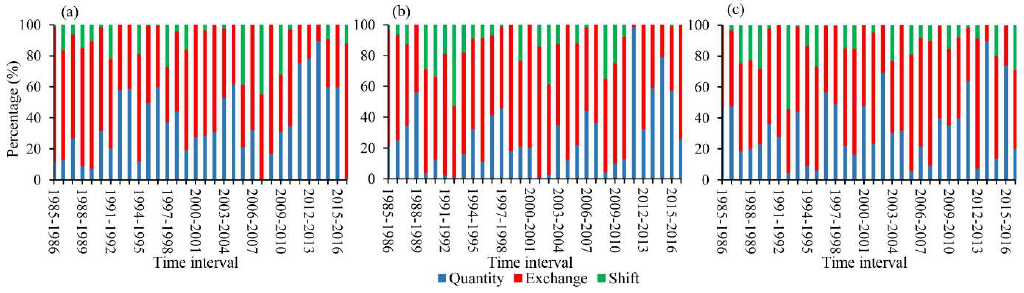
Figure 6. Percentage of water change components in ( a ) upstream, ( b ) midstream, and ( c ) downstream regions.